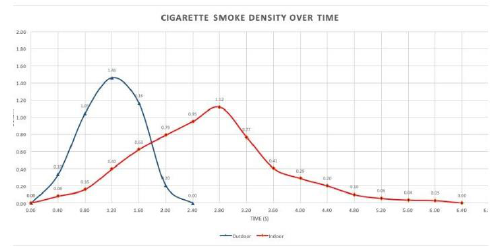
Figure 17. 2D Graph of Cigarette Smoke Density vs Time